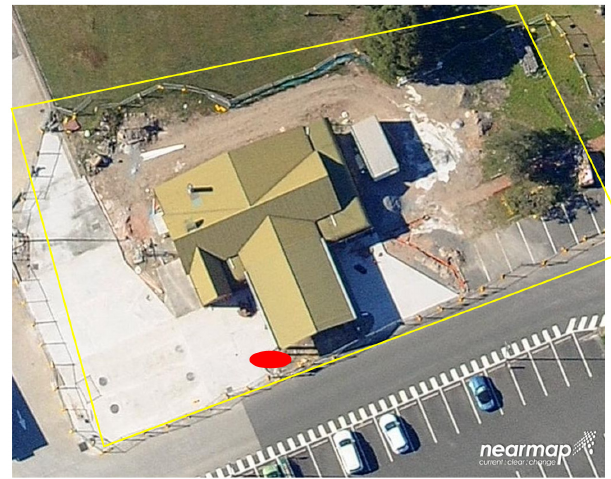
Figure 4. Aerial photograph of Lakewood refuelling site with approximate property boundary shown by yellow line.